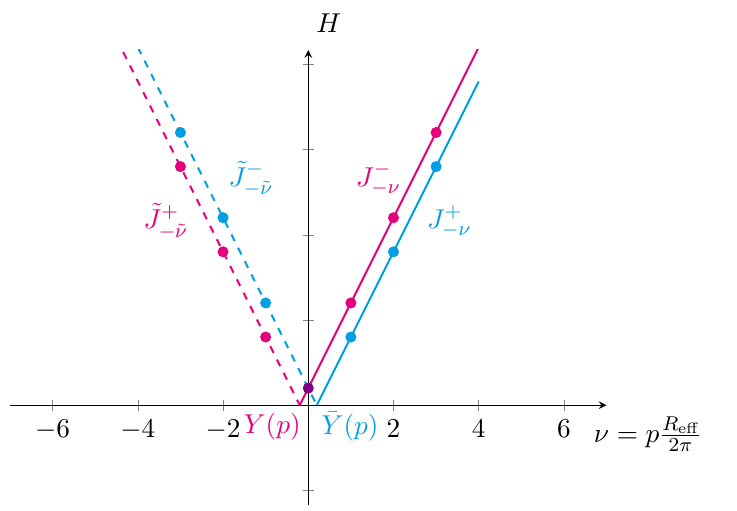
Figure 2 . Some excitations in the spectrally un(cid:13)owed sector. We plot in red the dispersion H ( p ) for the excitation Y ( p ), and in cyan the one for (cid:22) Y ( p ). The position of the cusp where kp = (cid:0) (cid:22)R e(cid:11) is close to zero | more precisely, it lies in the interval ( (cid:0) 1 ; +1). We highlight the allowed mode numbers with dots; the mode numbers falling on the positive slopes (solid lines) correspond to chiral excitations J (cid:6) while the ones on the negative slopes (dashed lines) correspond to anti-chiral ones, (cid:0) (cid:23) ~ J (cid:6) . The only allowed zero-modes are those of J (cid:0) and ~ J (cid:0) , as required by the WZW construction, (cid:0) ~ (cid:23) see also appendix